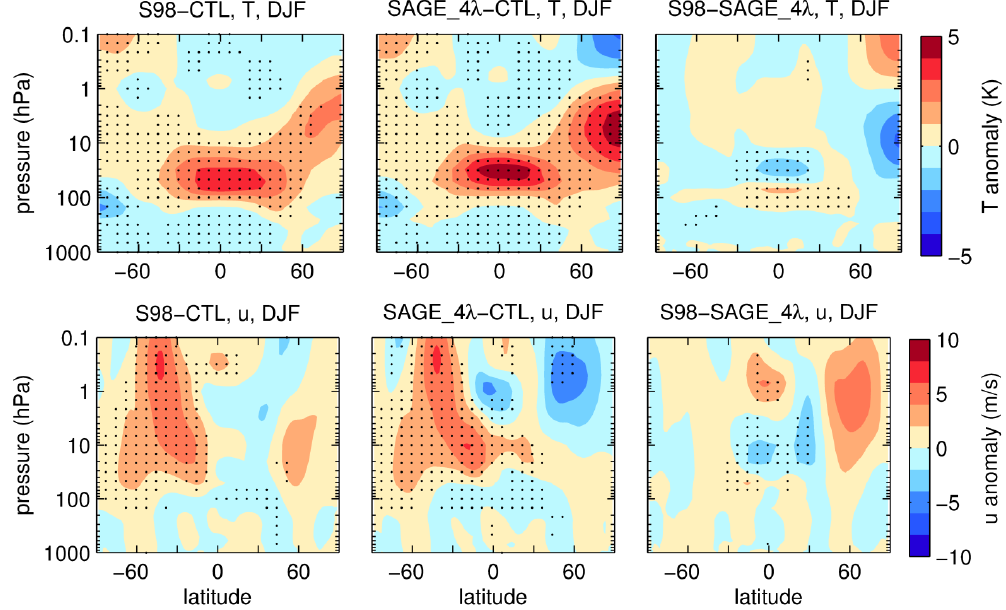
Figure 7. Temperature and zonal wind response of the observation-based volcanic forced ensembles. Shown are DJF anomalies for the (left) S98 and (middle) SAGE_4 λ ensembles, and (right) the difference between the two ensembles for (top) temperature and (bottom) zonal wind. Stippling highlights anomalies that are significant at the 95% confidence level based on a bootstrapping algorithm.